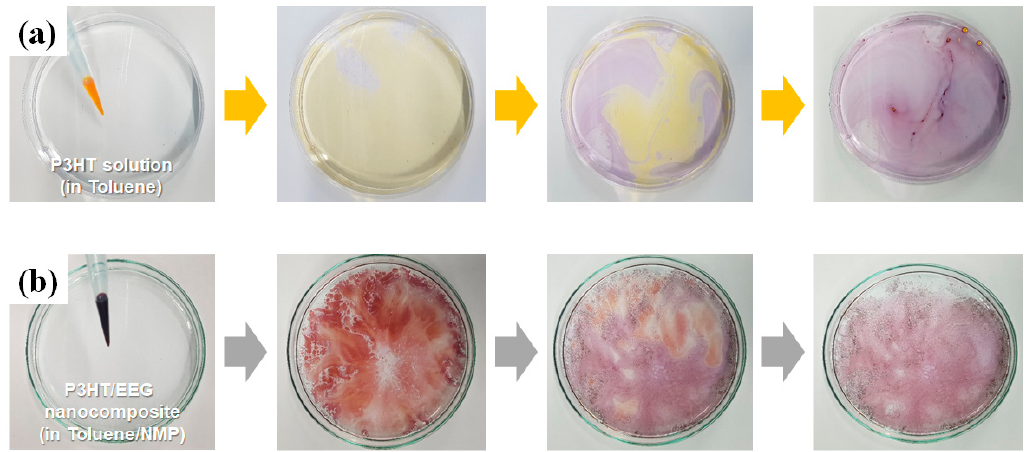
Figure 2. Digital images of fabrication process of ( a ) pristine P3HT and ( b ) P3HT / EEG nanocomposite films via solution floating method.